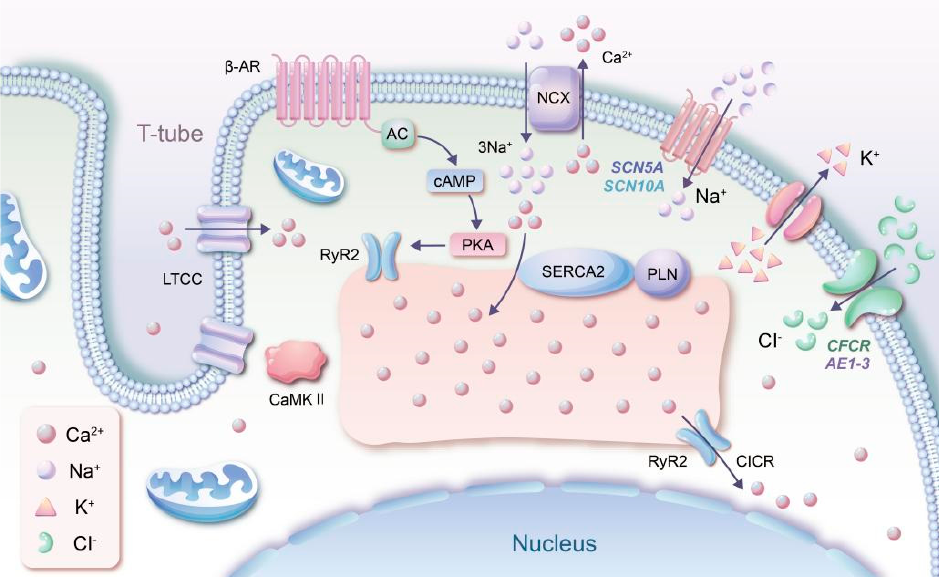
Figure 1. The surface of the cardiomyocyte membrane is recessed to form a T-tube structure on which LTCC calcium ion channels are distributed. The other ion channels are the Na–Ca exchanger NCX, Na channels ( SCN5A , SCN10A ), K channels ( KCNN ), Cl channels ( CFCR , AE1 − 3 ) and the G protein-coupled receptor β -AR. Inside the cells there is a SR/ER that stores Ca 2+ . On the surface of the SR/ER are RyR2, SERCA2, PLN and the cytoplasmic CaMKII calcium-regulated kinase, which together mediate the flow of Ca 2+ into the SR/ER and its release. The ion channels mentioned in the figure all have papers suggesting that variants of ion channel proteins and related proteins would have an impact on the pathogenesis of ACM. These papers are reviewed in the relevant sections.